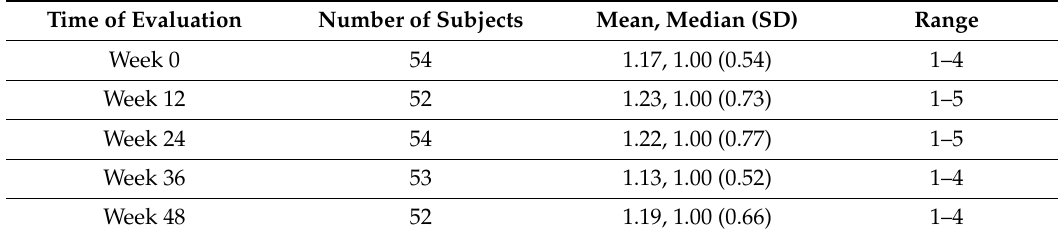
Table 2. Summary of normalized backward digit span over time in